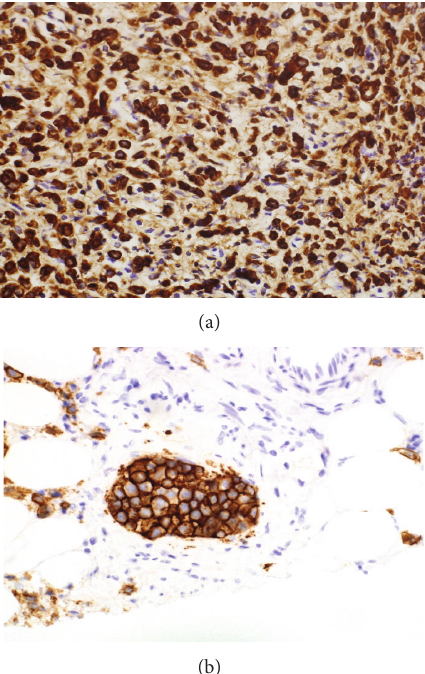
Figure 3: (a) Biopsy from the axillary mass shows infiltration by similarpoorlydifferentiatedneoplasticcells.Thecellswherepositive for (b) HER2/neu. The overall findings were consistent with poorly differentiated adenocarcinoma of primary breast origin, most likely invasive ductal carcinoma.